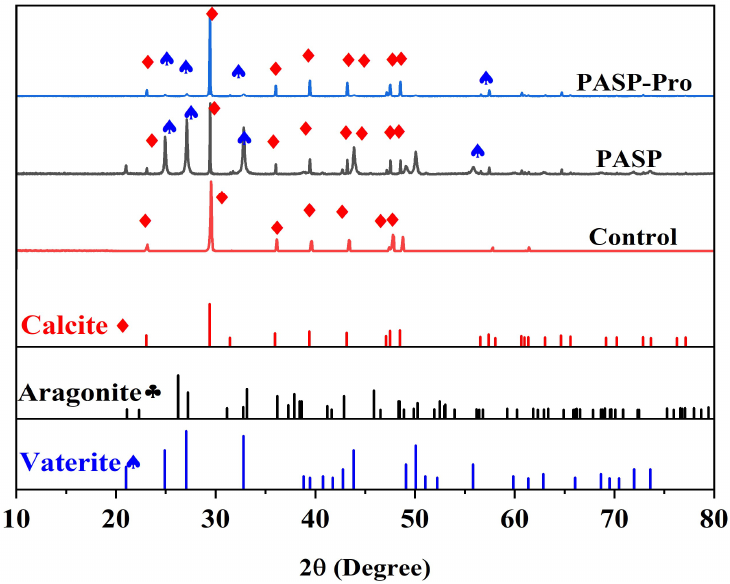
Figure 9. The XRD patterns of the CaCO 3 crystals. Table 2. Relative content of calcium carbonate crystal. Relative Content (%)